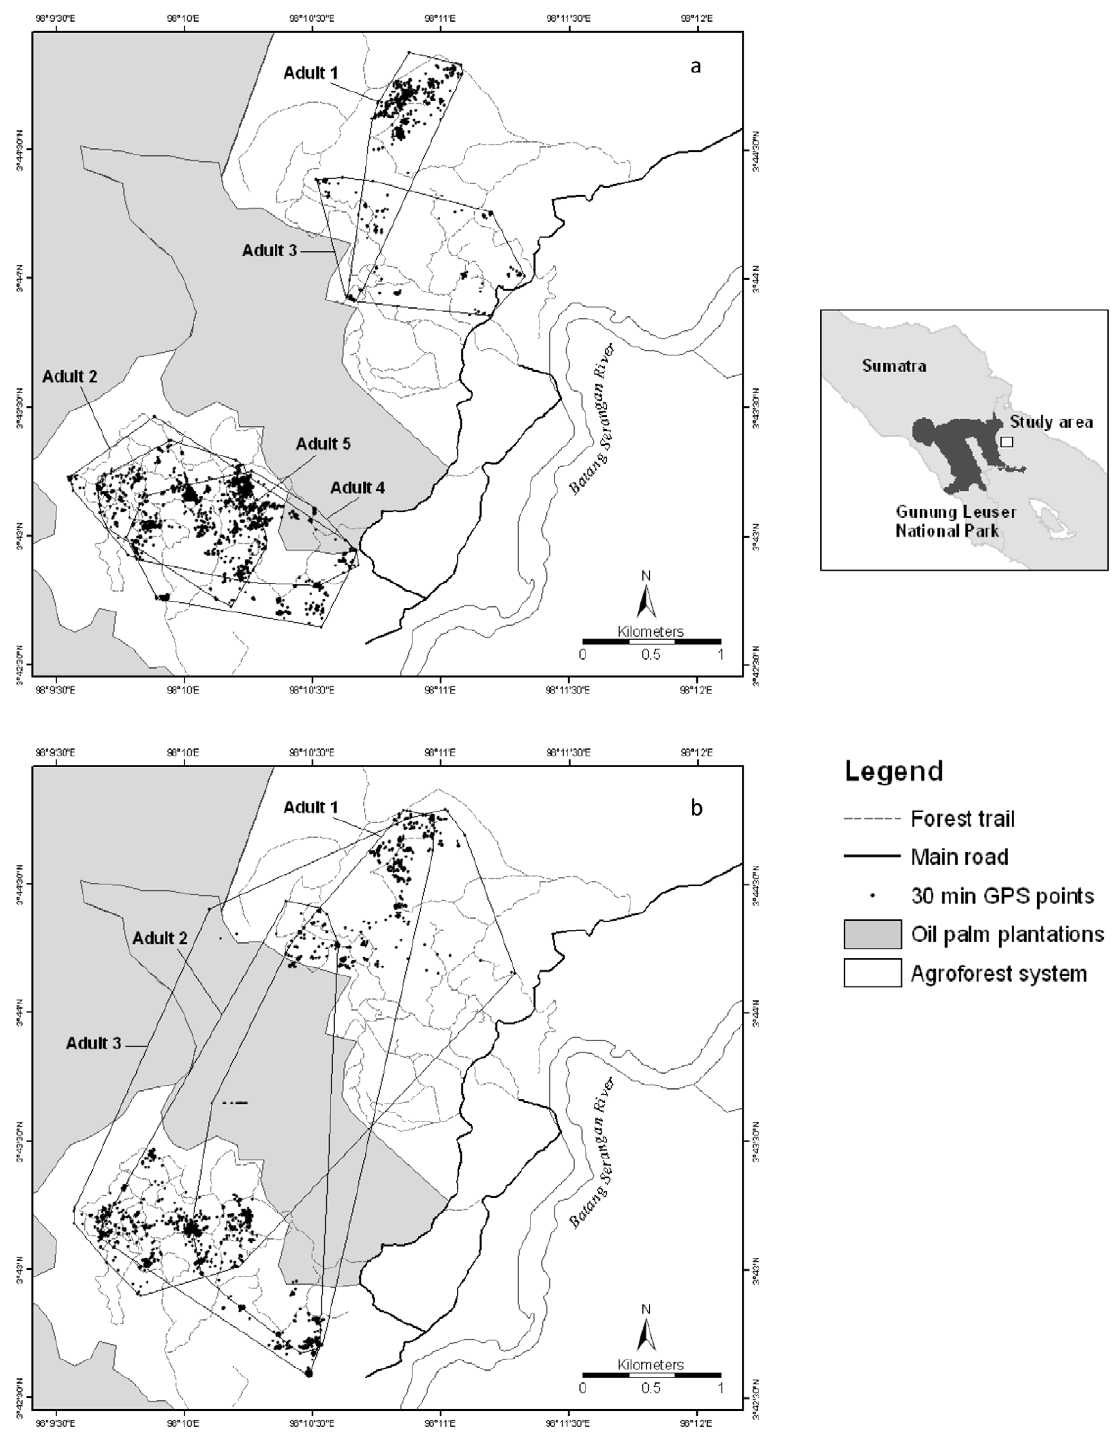
Figure 1. Orangutan home range patterns for (a) five adult females (2936 data points) and (b) three adult males (2034 data points) in Batang Serangan, North Sumatra. doi:10.1371/journal.pone.0017210.g001 [27]. Home range sizes were calculated using the three methods commonly used in non-human primate studies [26,28,29,30]: a minimum convex polygon (MCP) method; a 100 m 6 100 m resolution grid cell-based method; and, a fixed kernel density estimation (KDE) method, taken at the 95% and 50% values.